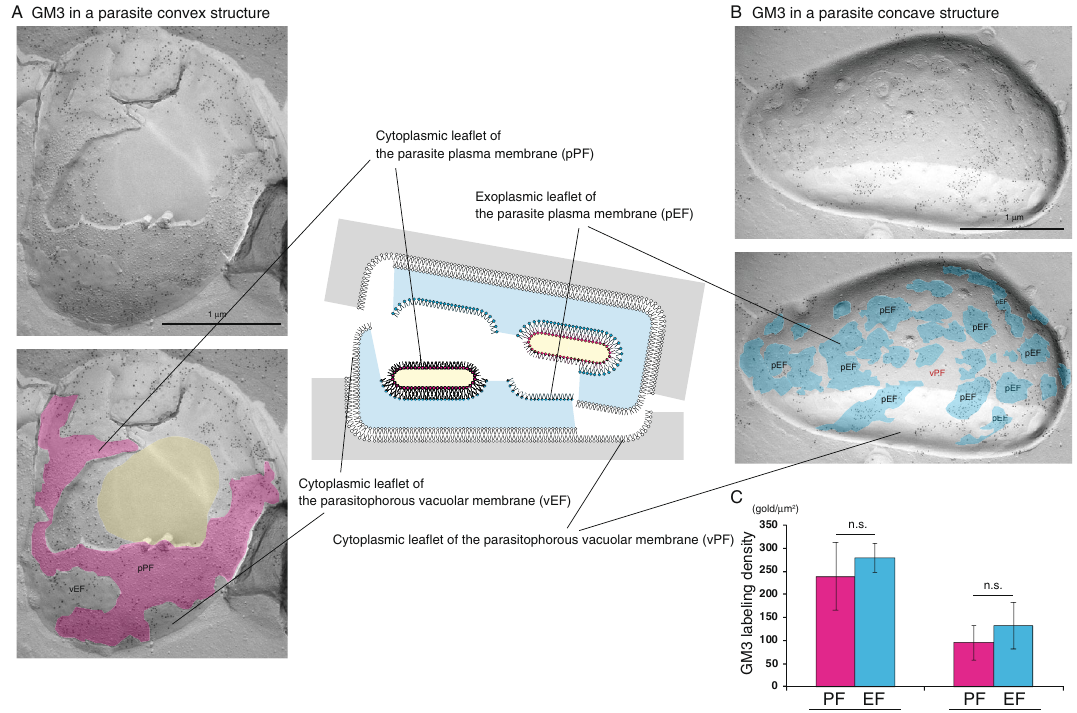
Figure 3. Raft component GM3 is localized in both the EF and the PF of the P. falciparum plasma membrane. In P. falciparum , the labeling of GM3 was detected on both the pPF ( A , pink) and pEF ( B , blue) leaflets of the plasma membrane. GM3 labeling was also observed on the PV membrane EF (vEF in A ) and PV membrane PF (vPF in B ). The cytoplasm of P. falciparum is colored with yellow (lower panel in A ). Scale bars: 1 μm. ( C ) Labeling density of GM3 in the P. falciparum membrane and PV membrane in each leaflet. The labeling densities of GM3 on the PF (pink) and the EF (blue) of the P. falciparum plasma membrane and the PV membrane in the erythrocyte are shown. The gold labeling densities on the PF of the parasite plasma membrane and the PV membrane were comparable to those on the EF of each membrane. The mean ± s.e.m. of three independent experiments is shown. The labeling densities of GM3 on the PF were not significantly different (n.s., Student’s t -test) from those on the EF of both the P. falciparum plasma membrane and PV